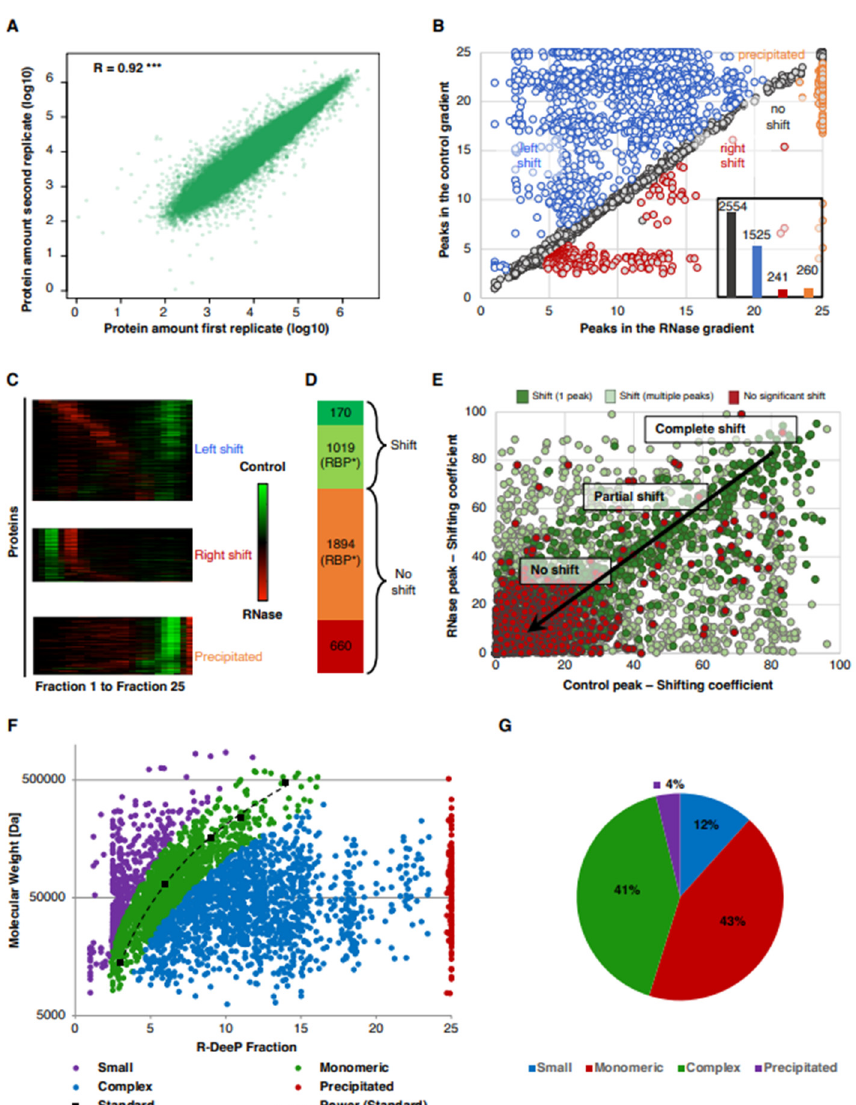
Figure 2. Proteome-wide R-DeeP screen in A549 cells. ( A ): The amount of each protein per fraction in different replicates after fraction-wise normalization is depicted documenting the reproducibility of the experiment. Pearson’s correlation coefficient R = 0.92, *** p -value < 0.001. ( B ): The graph shows the position of maxima in control and RNase-treated samples for each shift based on the mean of three replicates. The inset bar graph shows the number of proteins shifting left (blue) or right (red) or not (gray) or precipitating (orange). ( C ): A heatmap shows the significant shifts categorized for the direction of shift (left shift, right shift or precipitation). Green color represents protein enrich- ment in control fractions while red color represents protein enrichment in the RNase-treated frac- tions ( D ): The panel shows the number of shifting and non-shifting proteins detected in this R-DeeP screen grouped according to their identification as RBP candidates (RBP*) in 43 previous proteome- wide human studies as well as novel RBP candidates (n = 170). ( E ): The graph depicts the shifting co-efficient (protein amount at maxima × loss or gain by the shift) for each pair of control and RNase peaks. Red dots indicate proteins with no significant shifts, dark green depicts proteins with signif- icant shifts between one control and one RNase-treated peaks and light green represents proteins with multiple peaks. The top right region of the graph represents proteins with a “complete shift” (almost the entire amount of the protein is shifting), bottom left indicates proteins with no shift and the candidates that lie in the middle are the proteins with a partial shift (a fraction of the protein is shifting, while another fraction does not show RNA dependence). ( F ): The graph shows the molec- ular weight and position of the maxima for the reference proteins in the gradient (black). The mo- lecular weights of the reference proteins are RNase A (14 kDa), BSA (60 kDa), Aldolase (4 × 40 kDa = 160 kDa), Catalase (4 × 60 kDa = 240 kDa), and Ferritin (24 × 20 kDa = 480 kDa). The dashed black